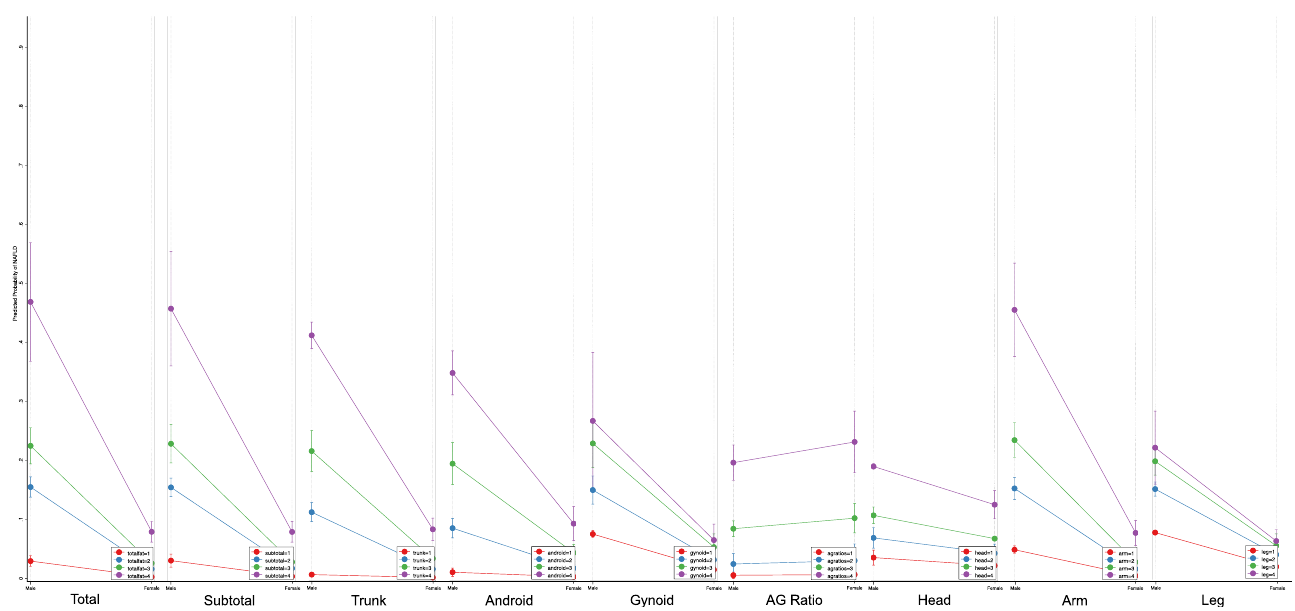
Figure 2. Predictive Probability of Regional Body Fat Percentages and Risk of NAFLD Development in Non-obese Population.